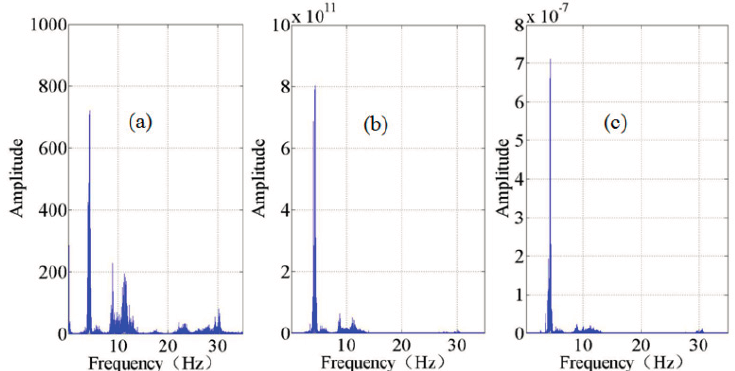
Figure 9. Typical recordings in the frequency domain: ( a ) accelerometer; ( b ) cableless geophone; and ( c ) 4.5 Hz